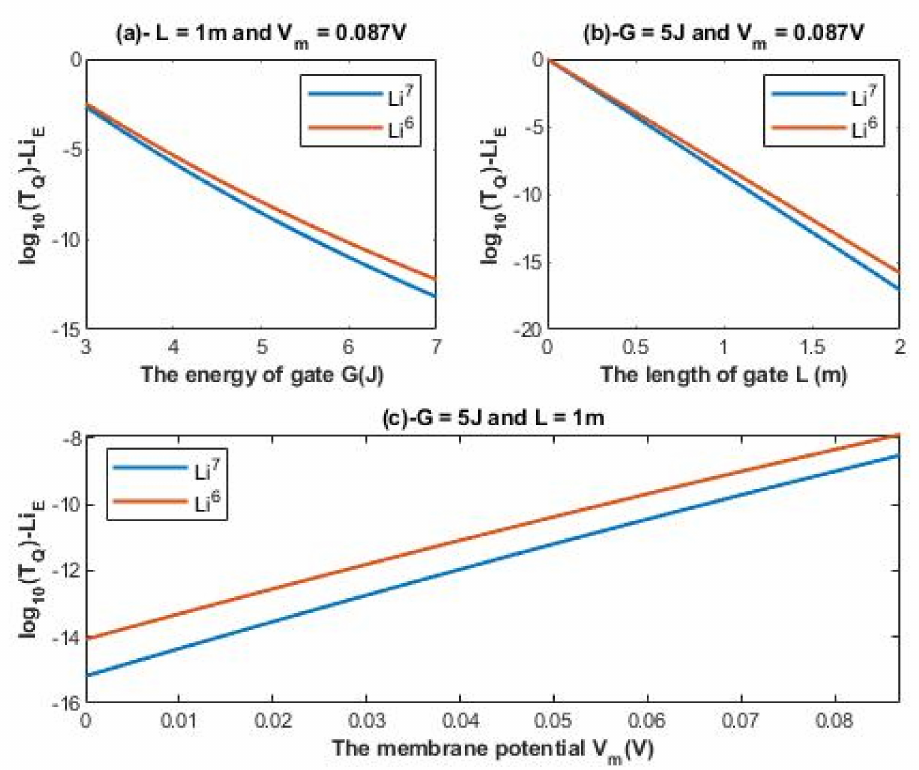
Figure 2. ( a ): The figure represents the relationship between the common logarithm of tunneling ( T ) − Li probability of the extracellular lithium isotopes log E and the energy of the gate G by Q 10 setting L = 1 m and V m = 0.087 V and across the range of G from 3 J to 7 J. ( b ): The figure represents the relationship between the common logarithm of tunneling probability of the extracellular lithium ( T ) − Li = 5 m and V m = 0.087 V and isotopes log E and the length of the gate L by setting G Q 10 across the range of L from 0 m to 2 m. ( c ): The figure represents the relationship between the common ( T ) − Li logarithm of tunneling probability of the extracellular lithium isotopes log E and the Q 10 membrane potential by setting G = 5 J and L = 1 m and across the range of membrane potential from 0 V to 0.087